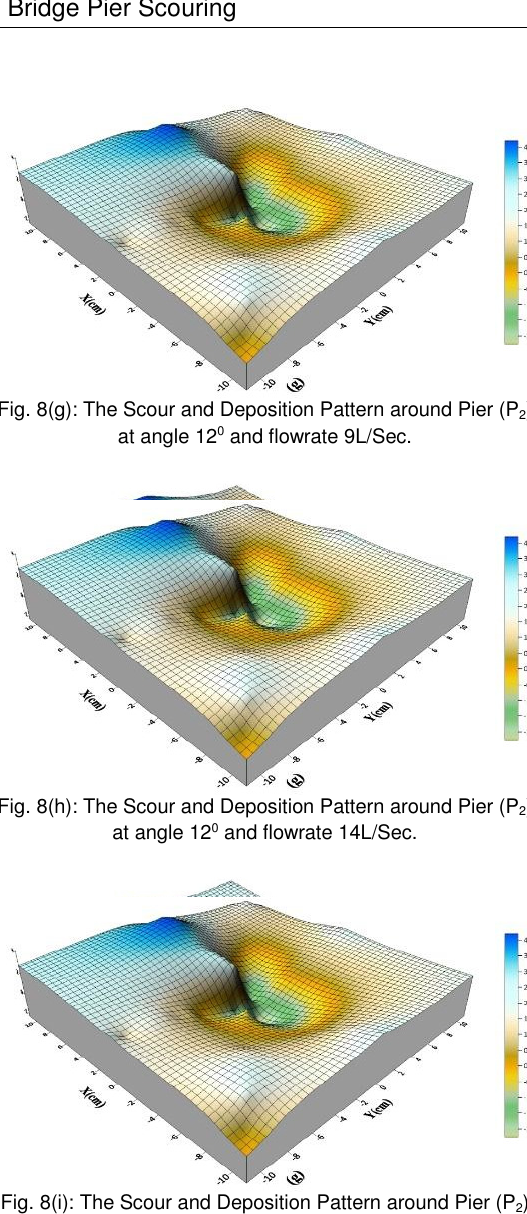
Fig. 8(i): The Scour and Deposition Pattern around Pier (P 2 ) at angle 12 0 and flowrate 18L/Sec. The green area denotes maximum Scouring pattern